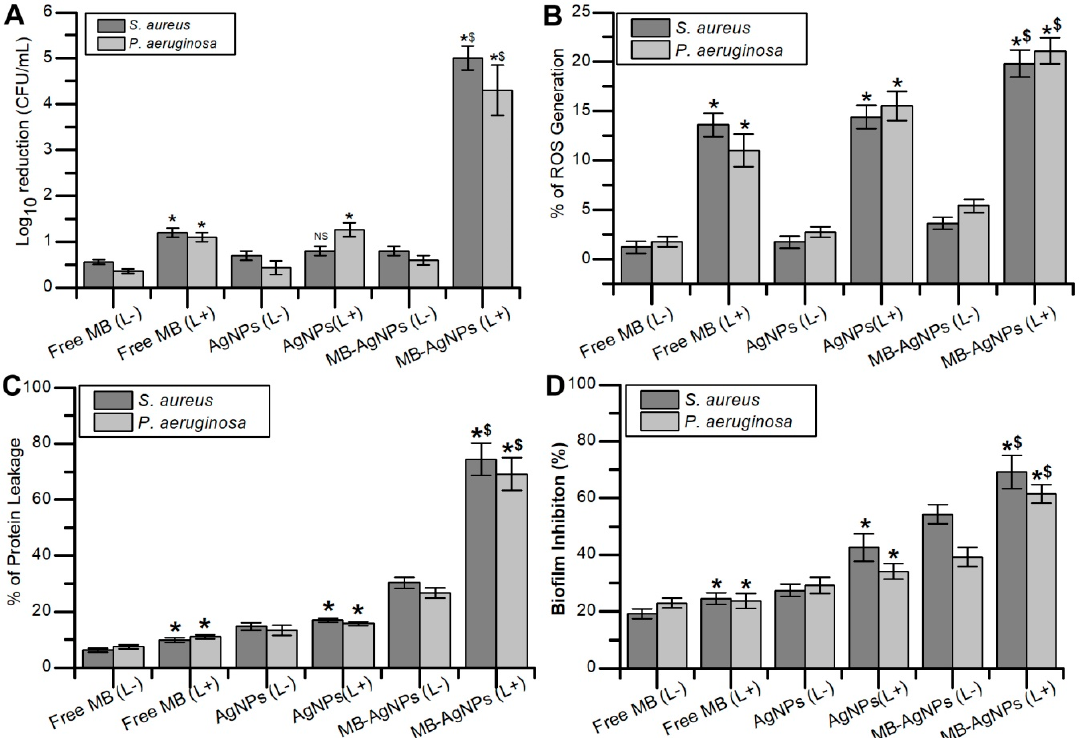
Figure 5. ( A ) Antimicrobial photodynamic killing of free floating bacteria with MB, AgNPs, and MB-AgNPs. ( B ) The percentage of ROS generated after aPDT against S. aureus and P. aeruginosa . ( C ) The percentage protein leakage from S. aureus and P. aeruginosa after treatment with MB, AgNPs, and MB-AgNPs. ( D ) Effect of aPDT on biofilm formation in the bacterial samples treated with free MB, AgNPs, and MB-AgNPs in dark and light irradiation conditions. (L+) Light irradiation, (L − ) non-irradiation. Standard deviation of three independent experiments are represented on bar diagram with error bars. Asterisk denotes statistical difference compared with the respective dark control ( P < 0.05). Dollar represents a significant difference compared with free MB with irradiation ( P < 0.05). NS denotes no statistical significance with respect to control.